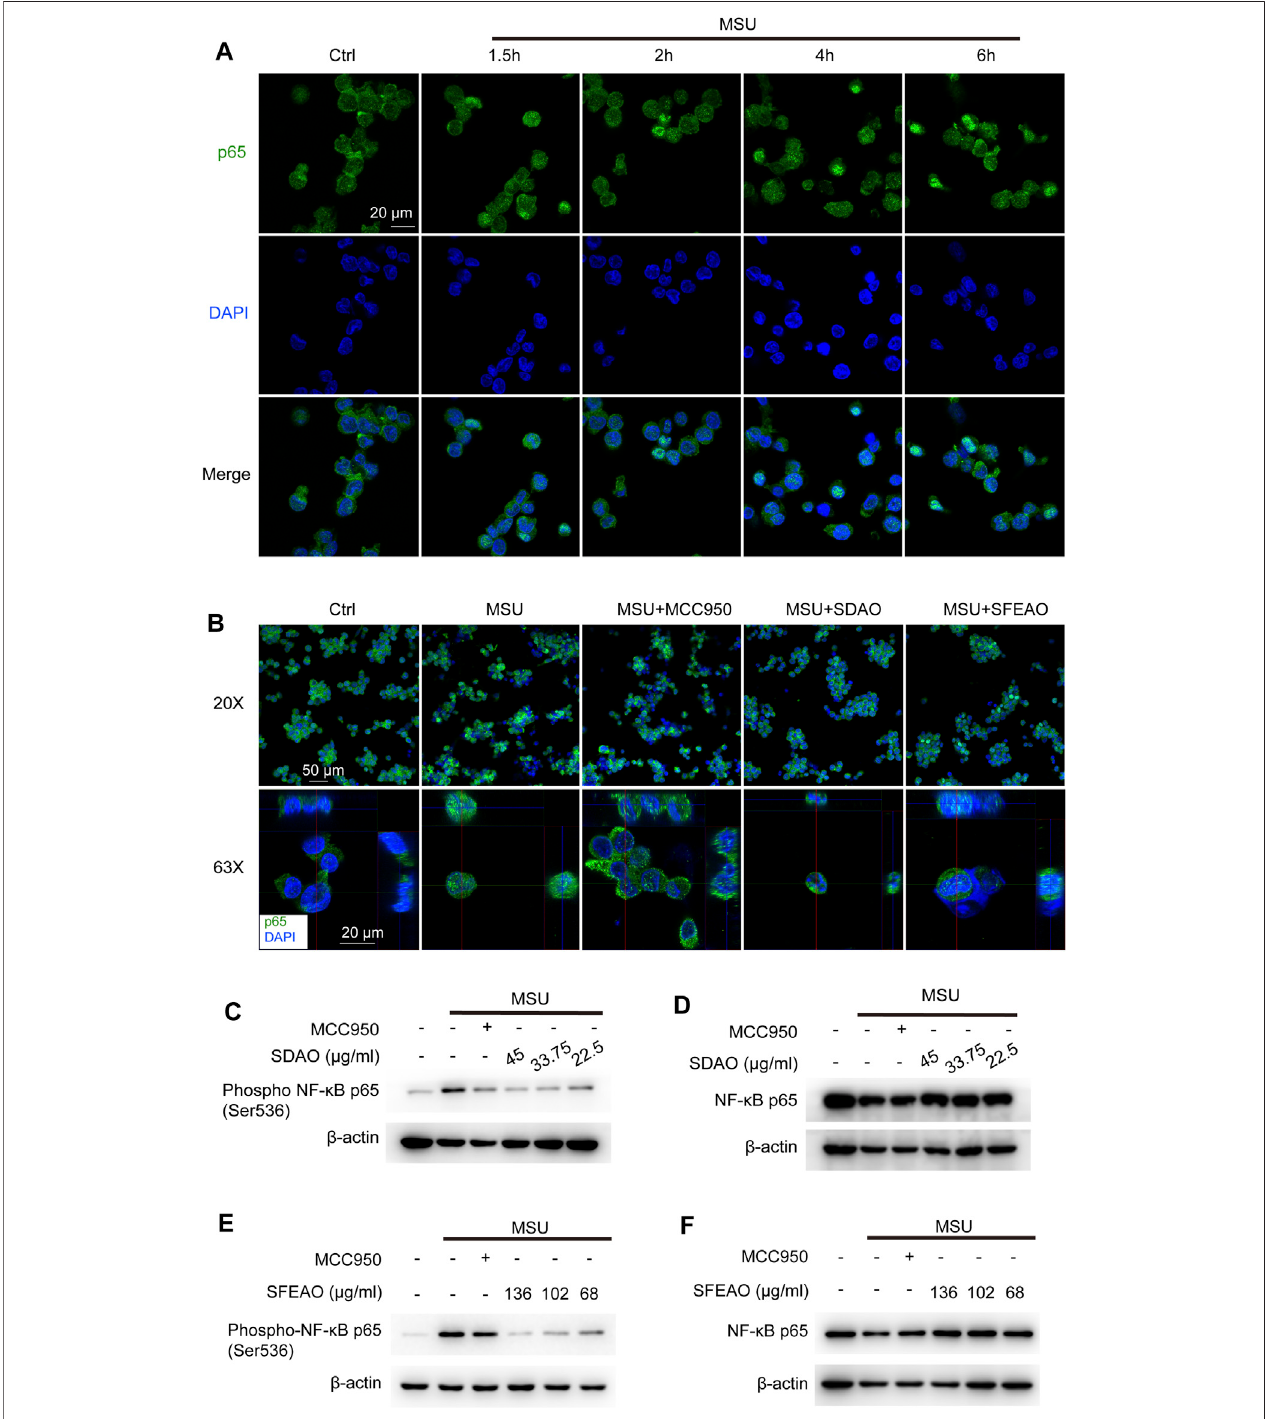
FIGURE4| EOAAinhibitsthenucleartranslocationofp65andphosphorylationofp65afterMSUstimulation.Thesubcellularlocalizationofp65wasdeterminedby indirect immuno fl uorescence using fl uorescence microscopy after staining with a p65 antibody (green). Nuclear DNA was revealed by DAPI staining (blue). (A) PMA- primed THP-1 cells were stimulated with MSU (500 μ g/ml) for different durations. (B) PMA-primed THP-1 cells were treated with or without MCC950 (20 μ M), SDAO (45 μ g/ml) or SFEAO (136 μ g/ml) upon stimulation with MSU (500 μ g/ml) for 6 h. Two magni fi cations of immuno fl uorescence pictures were acquired, and Z-stack pictures at 63X were processed using the Image software package for orthogonal view. The green and red lines in 63X images indicate the positions within the image of the projection given on the upper (XZ surface) and right (YZ surface), respectively. PMA-primed THP-1 cells were treated with or without MCC950 (20 μ M) or different concentrations of SDAO or SFEAO upon stimulation with MSU (500 μ g/ml) for 6 h. The protein expression levels of p-p65 (C , E) and NF- κ B p65 (D , F) in the cytoplasm were measured utilizing immunoblotting. β -Actin was acted as internal reference.